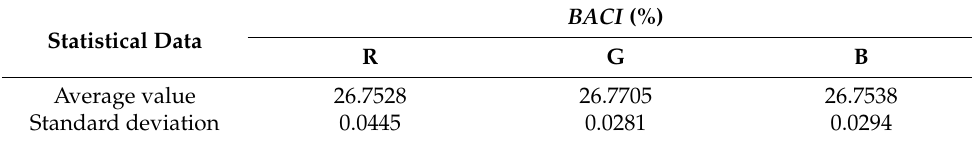
Table 9. Statistical results of BACI in Table